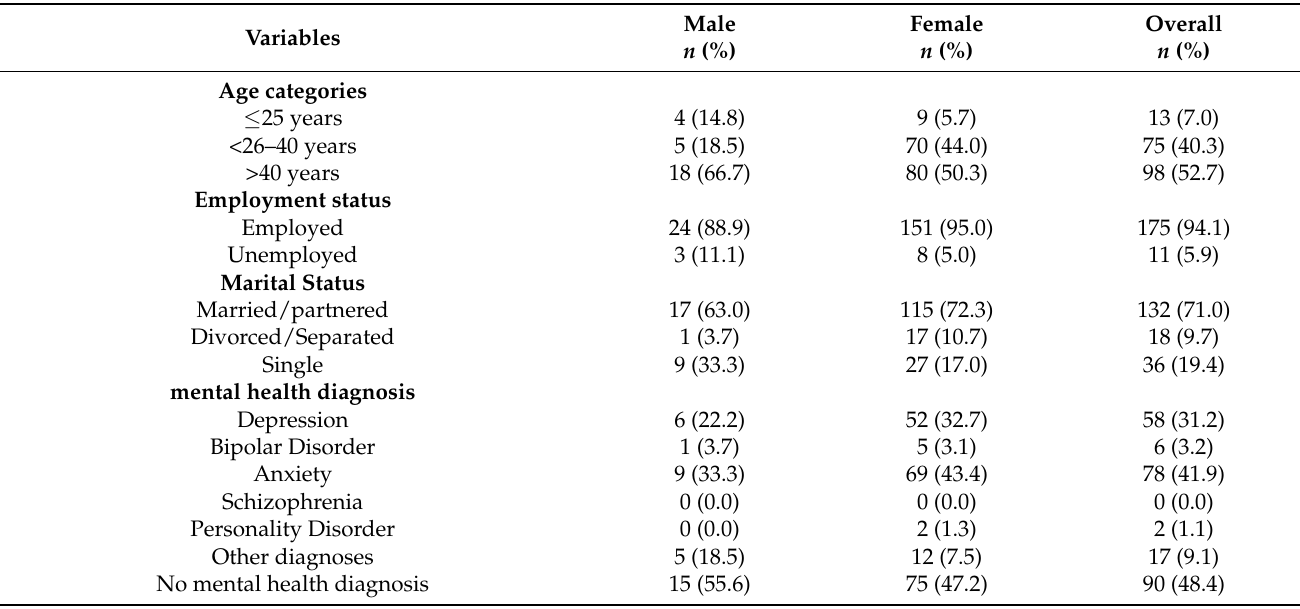
Table 1. Descriptive Characteristics of the